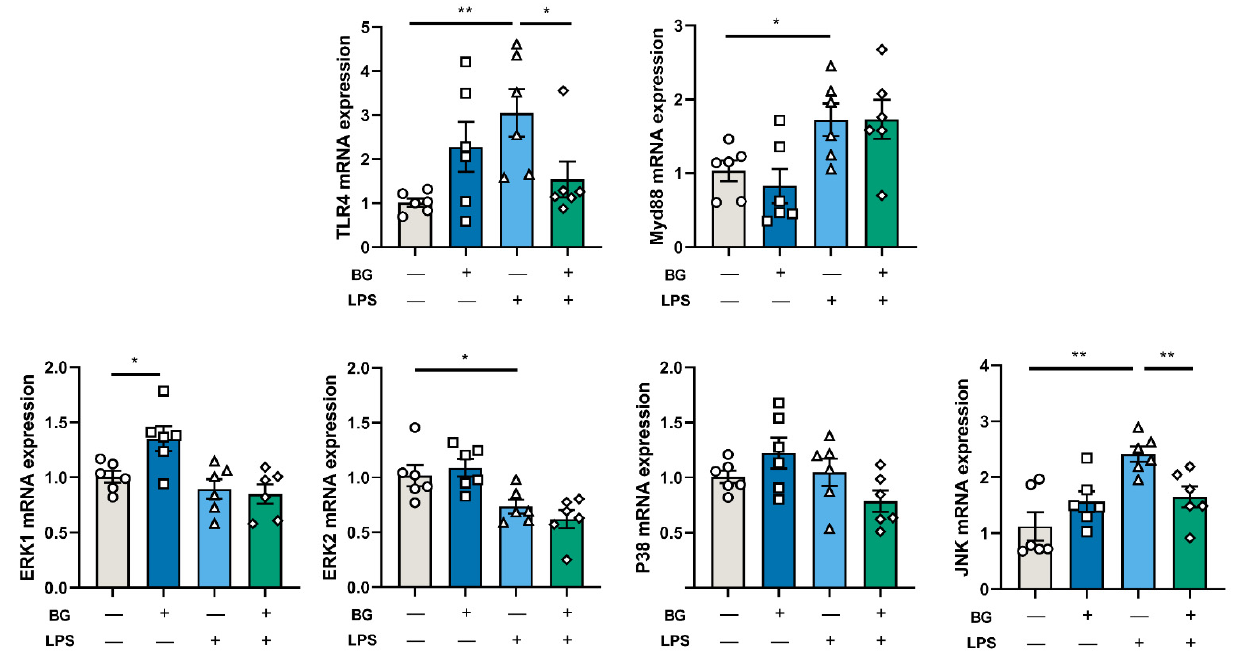
Figure 9. BG alleviated the mRNA expression increasing of TLR4/Myd88/JNK signal pathway in the ileum induced by LPS stimulation. Data are presented as mean ± SEM, n = 6. “+” and “ − ” mean with and without corresponding treatments, respectively. * and ** indicate significant difference ( p < 0.05 and p < 0.01, respectively). An unpaired t -test was used for statistical analysis between two groups.